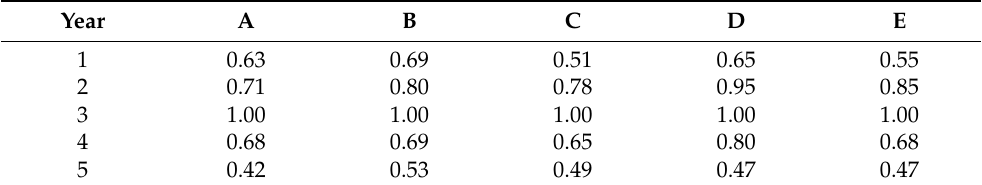
Table 2. Matrix C.